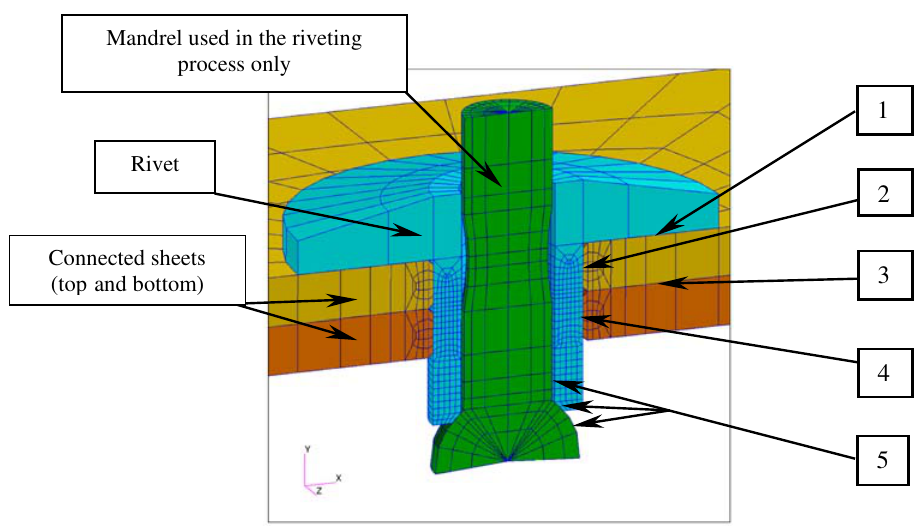
Fig 1. Model of joint components before riveting with the contact surfaces defined